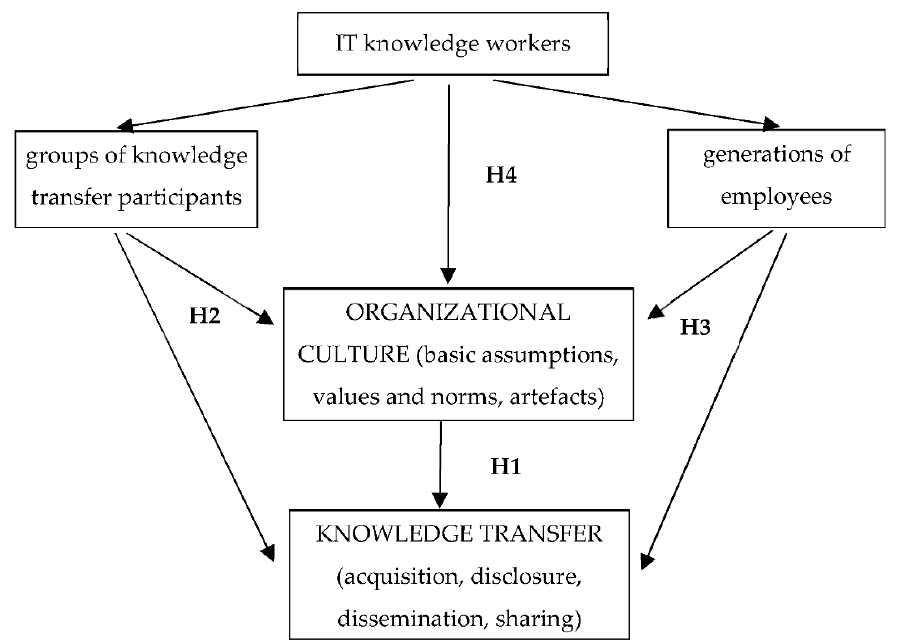
Figure 1. Conceptual model of hypotheses development.